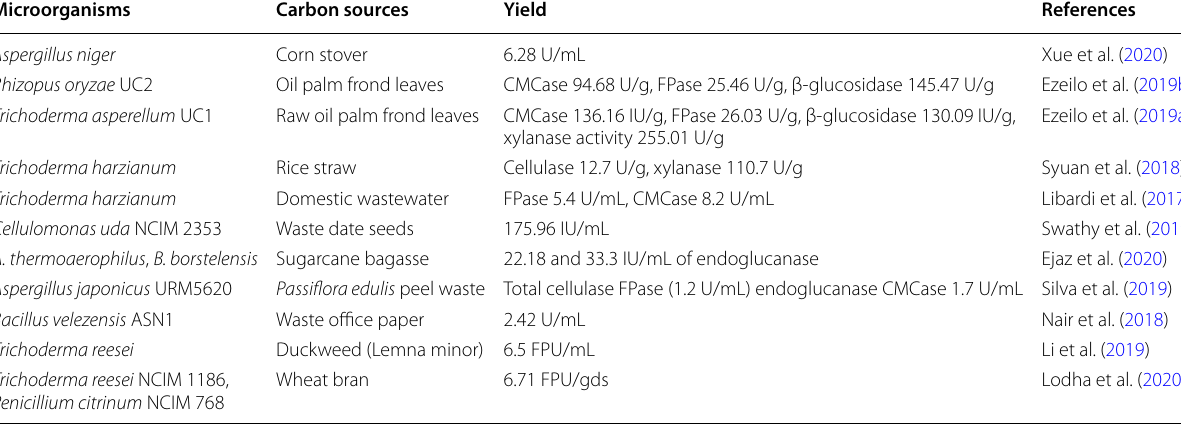
Table 1 Cellulases production potential of microbial strains by utilizing plant residues as carbon sources Microorganisms Carbon sources